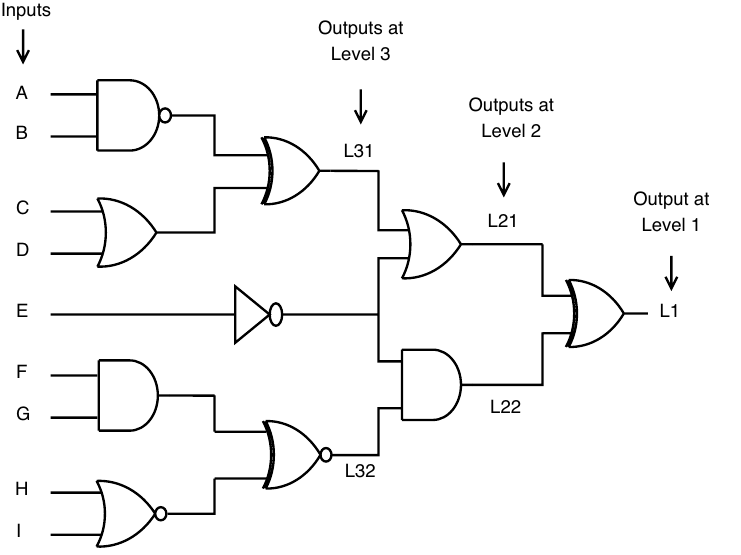
Figure 21. circuit with standard CMOS gates.